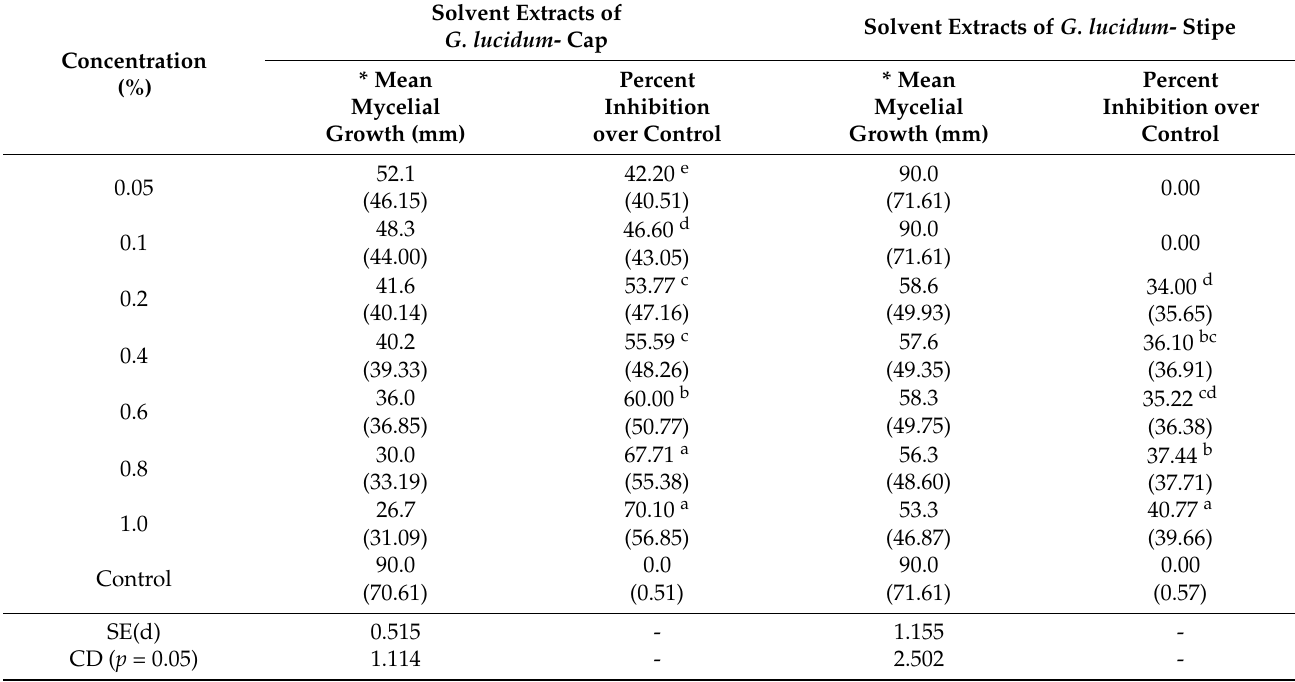
Table 1. Testing the ethyl acetate-extracted antimicrobial compound from the fruiting body (cap and stipe) of G. lucidum against C. gloeosporioides .